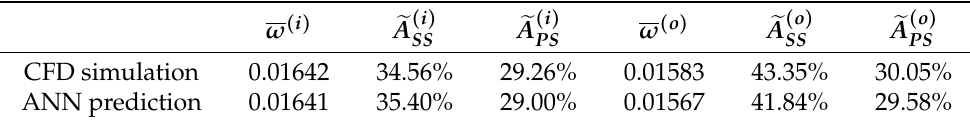
Table 6. Comparison of CFD simulation and ANN prediction on performance of the initial and optimized